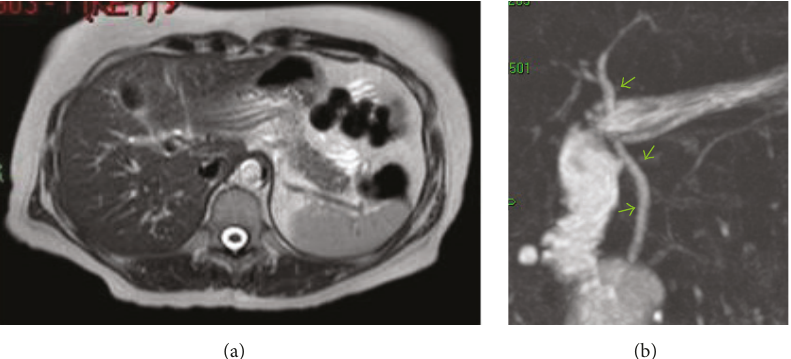
Figure 4: MRCP axial view (a) showing postcholecystectomy and resolved falciform ligament thrombosis. Projective coronal view (b) showing patent bile duct (green